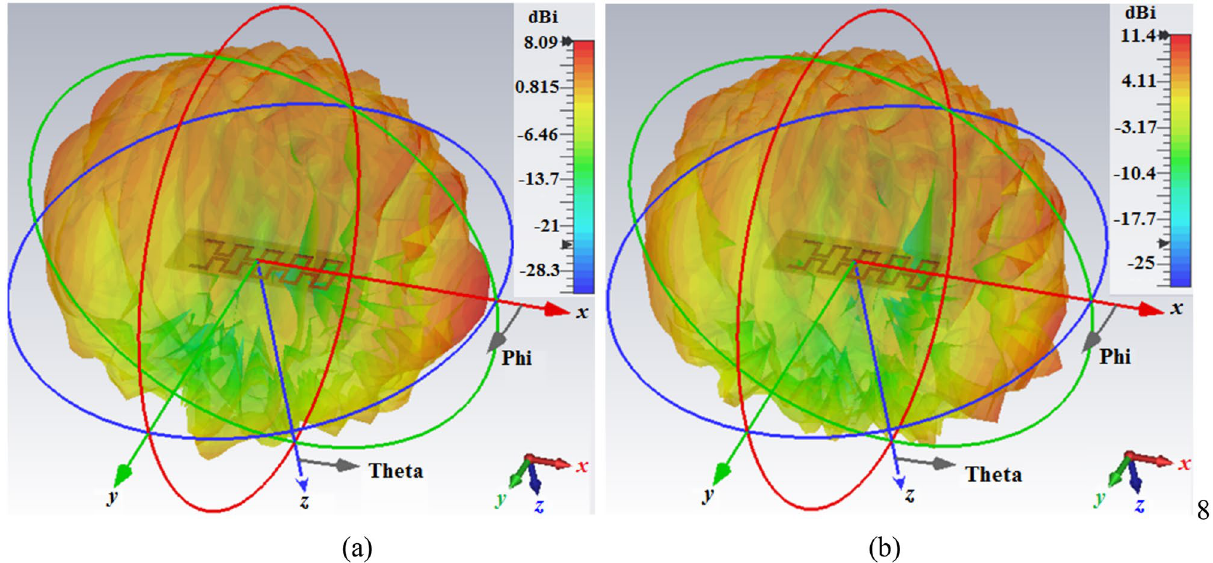
Figure 5. Radiation patterns of the proposed OCA with the MTM-IMC termination and slots at ( a ) 0.137 THz, and ( b ) 0.158